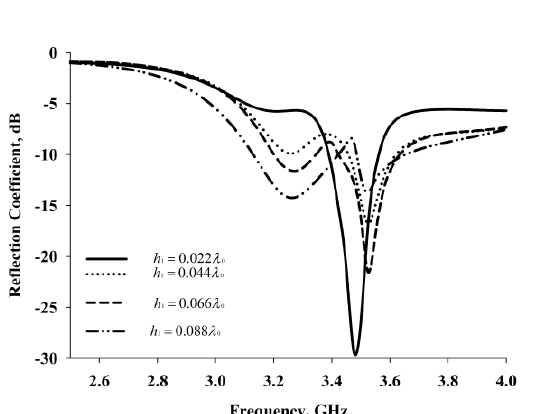
Figure 10: Effect of antenna loading height h